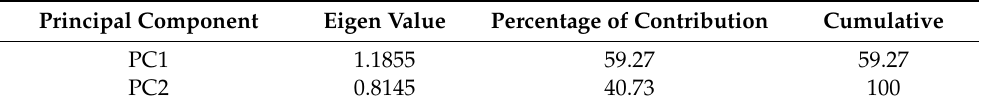
Table 6. Eigenvalues of principal components.